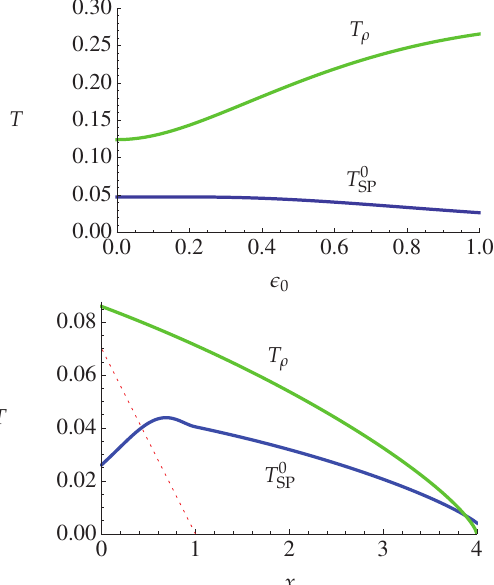
Figure 12. ( top ): Calculated variation of the mean-field SP ordering temperature T 0 Mott scale T ρ with the amplitude of site potential (cid:101) 0 due to charge ordering; ( bottom ): Calculated variations of the mean-field 1D (3D) spin-Peierls temperature T 0 tuning (pressure) parameter x . The dashed red line is a linear parametrization of the charge ordering temperature T CO = (cid:101) 0 ( x ) /2. All temperature scales are normalized by the average hopping t along the